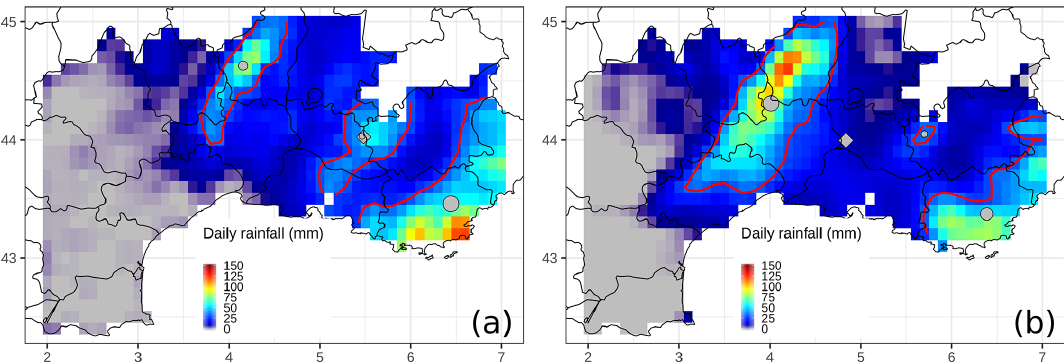
Figure 4. SAL pattern analysis for the case of 28 October 2004, applied to the observation data (a) and one 60h lead time forecast (b) . Base contours of the identified objects are shown as red lines. Grey points stand for the rain barycentre of each pattern, and the grey diamond depicts the rain barycentre for the whole field. The size of the barycentre points is proportional to the integrated mass of the associated